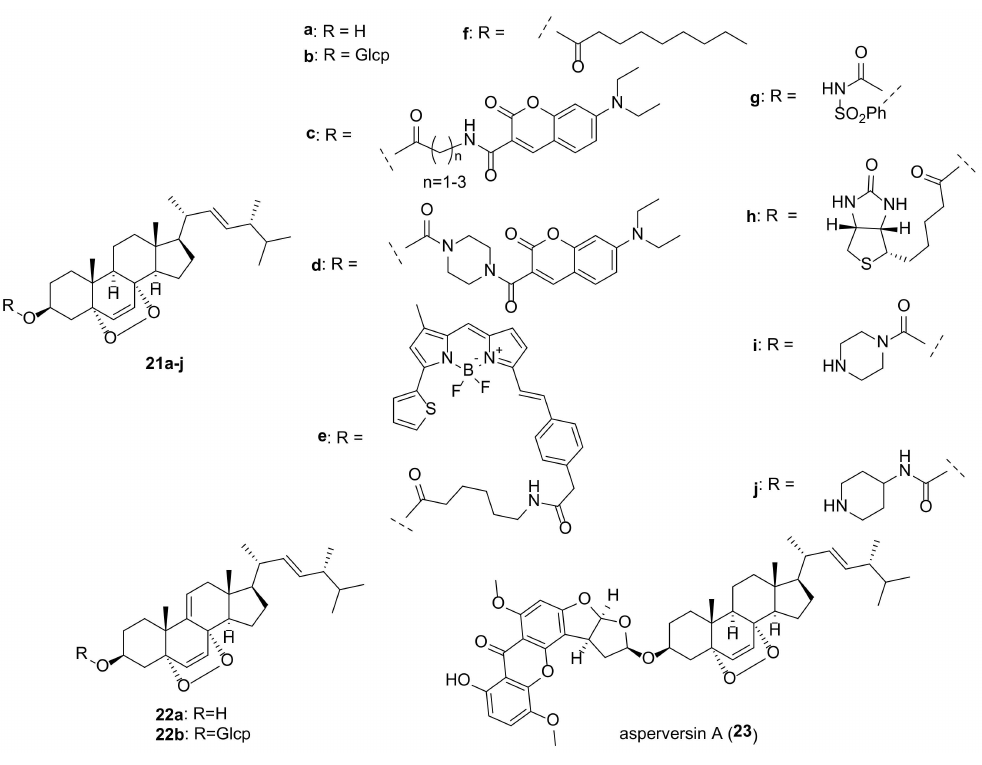
Figure 5. Structures of fungal 5 α ,8 α -endoperoxides and their O